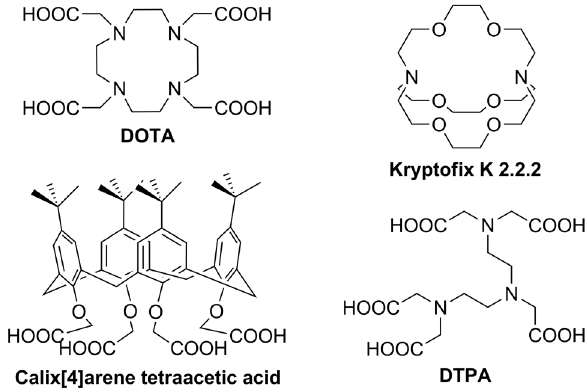
Figure 4: Compounds tested by Henriksen et al. for radium chelation and